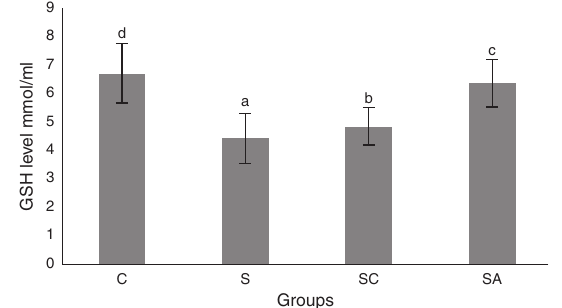
Figure 3 Glutathione (GSH) levels of the study groups. All groups showed a statistical difference from each other. Group S presented the lowest GSH level. C, control group; S, sinusitis group; SC, sinusitis + cefazolin group; SA, sinusitis + amlodipine group. Used the Used the analysis of variance (ANOVA) and LSD tests and were considered to be significant at p < 0.05 (all groups). The bars in the different serial shown by the differ- ent letters (a, b, c, and d) are statistically different from each other.